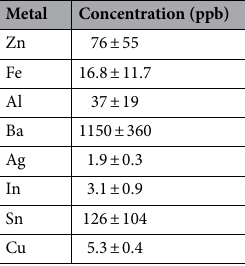
Table 3. Comparative ICP-OES elemental contaminant analysis of the [ 133/135 La]LaCl 3 product.